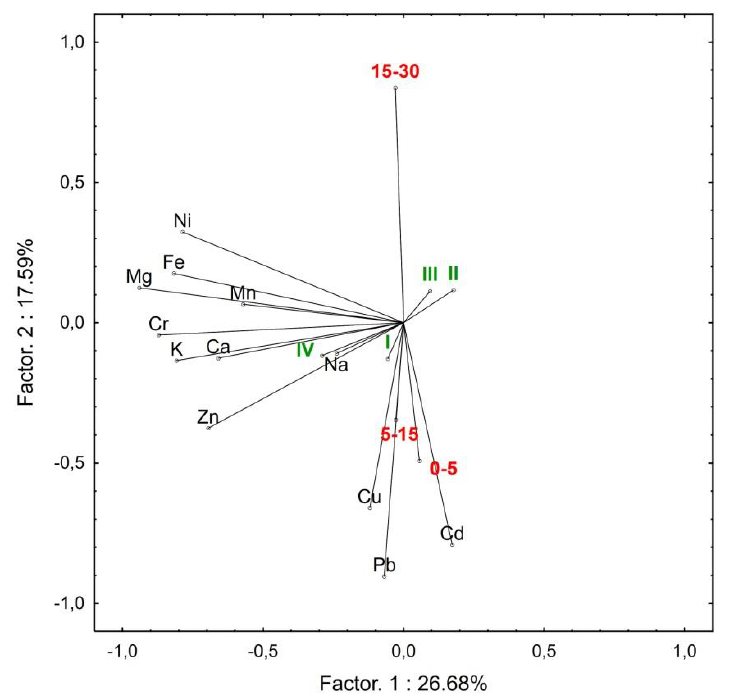
Figure 2. The projection of variables on a plane of the first and second PCA factors (I–IV—age class; 0–5, 5–15 and 15–30—soil